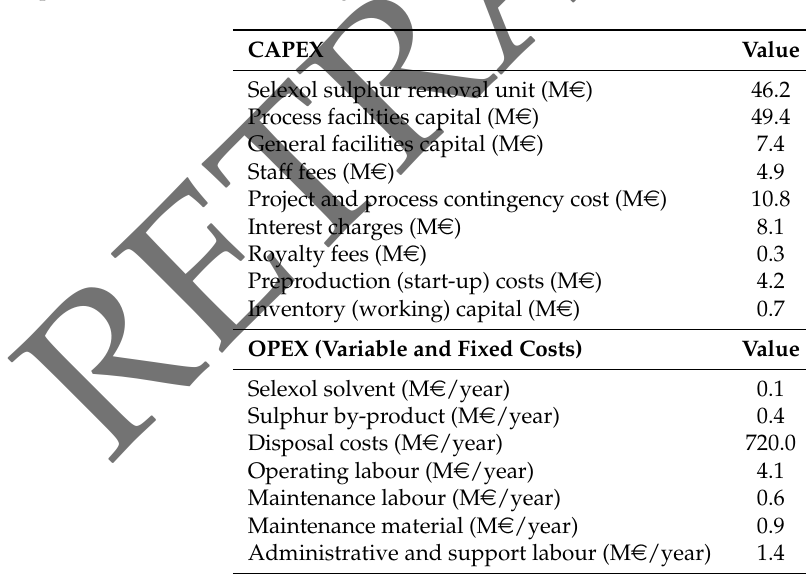
Table 8. Costs for synthesis gas processing in the electricity production scenario for 20 years of operation, modeled via the Integrated Environmental Control Model [29] and scaled